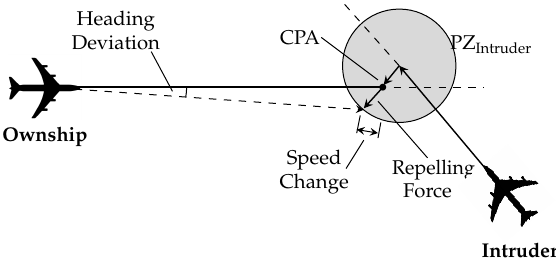
Figure 8. Modified Voltage Potential (MVP) resolution. Adapted from Hoekstra [21].